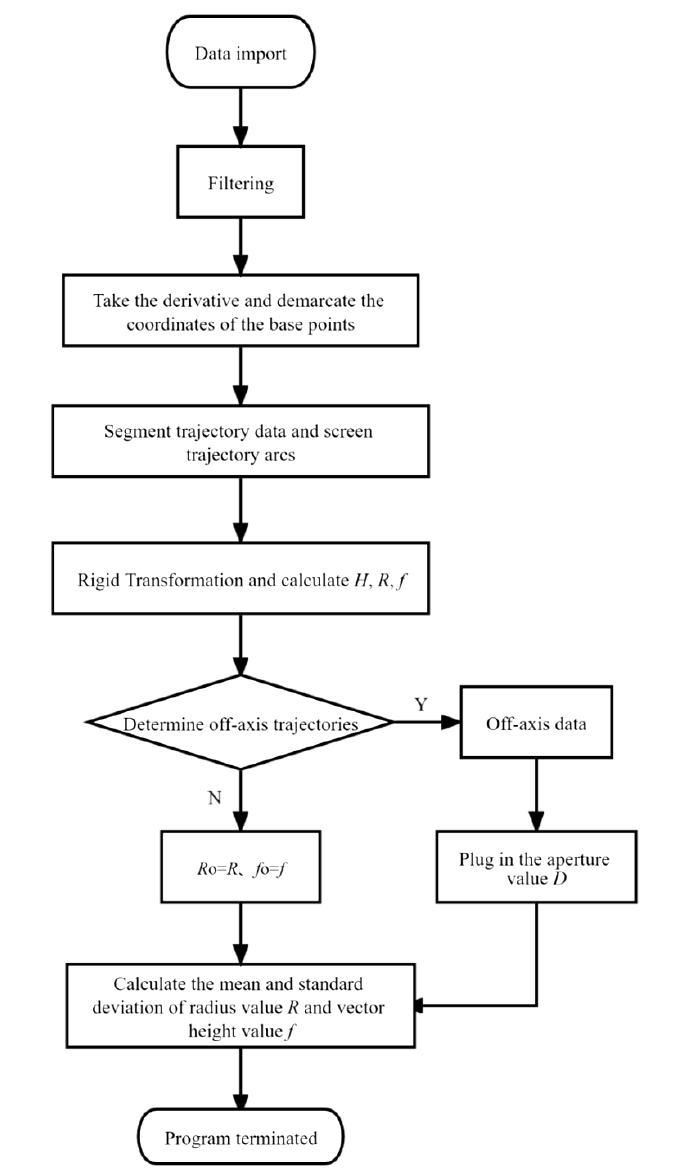
Figure 8. Data processing flow chart.